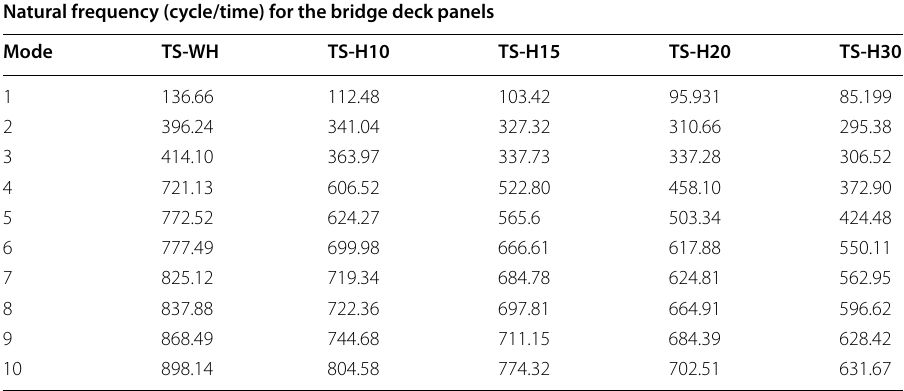
Table 5 Frequency of the sandwich plate with a transverse stiffener and with holes in the core layer Natural frequency (cycle/time) for the bridge deck panels